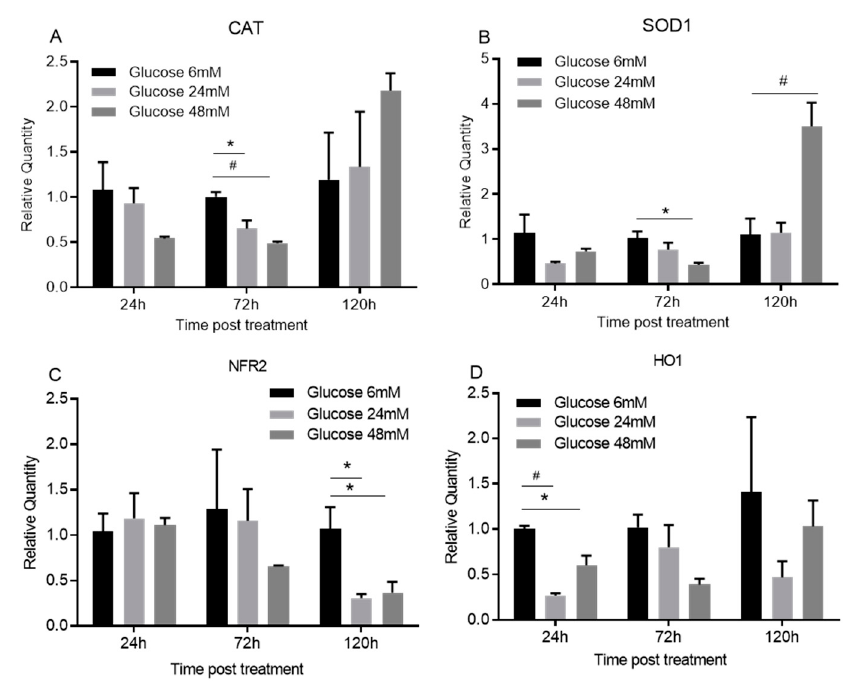
Figure 6. High glucose inhibits the expression of antioxidant enzymes in oral keratinocytes. TIGK cells treated with different concentrations of glucose (6, 24, 48 mM) were harvested. Total RNAs were extracted and cDNAs were prepared. Real time PCR was performed to detect the mRNA expression of CAT, SOD1, NFR2, and HO1. There were 3 replicates at each culture condition. The expression of the target genes in cells treated with 6 mM glucose at each time point was used as the baseline. * p < 0.05, # p < 0.01. One-way ANOVA followed by Tukey’s post-tests was used for statistical analysis.